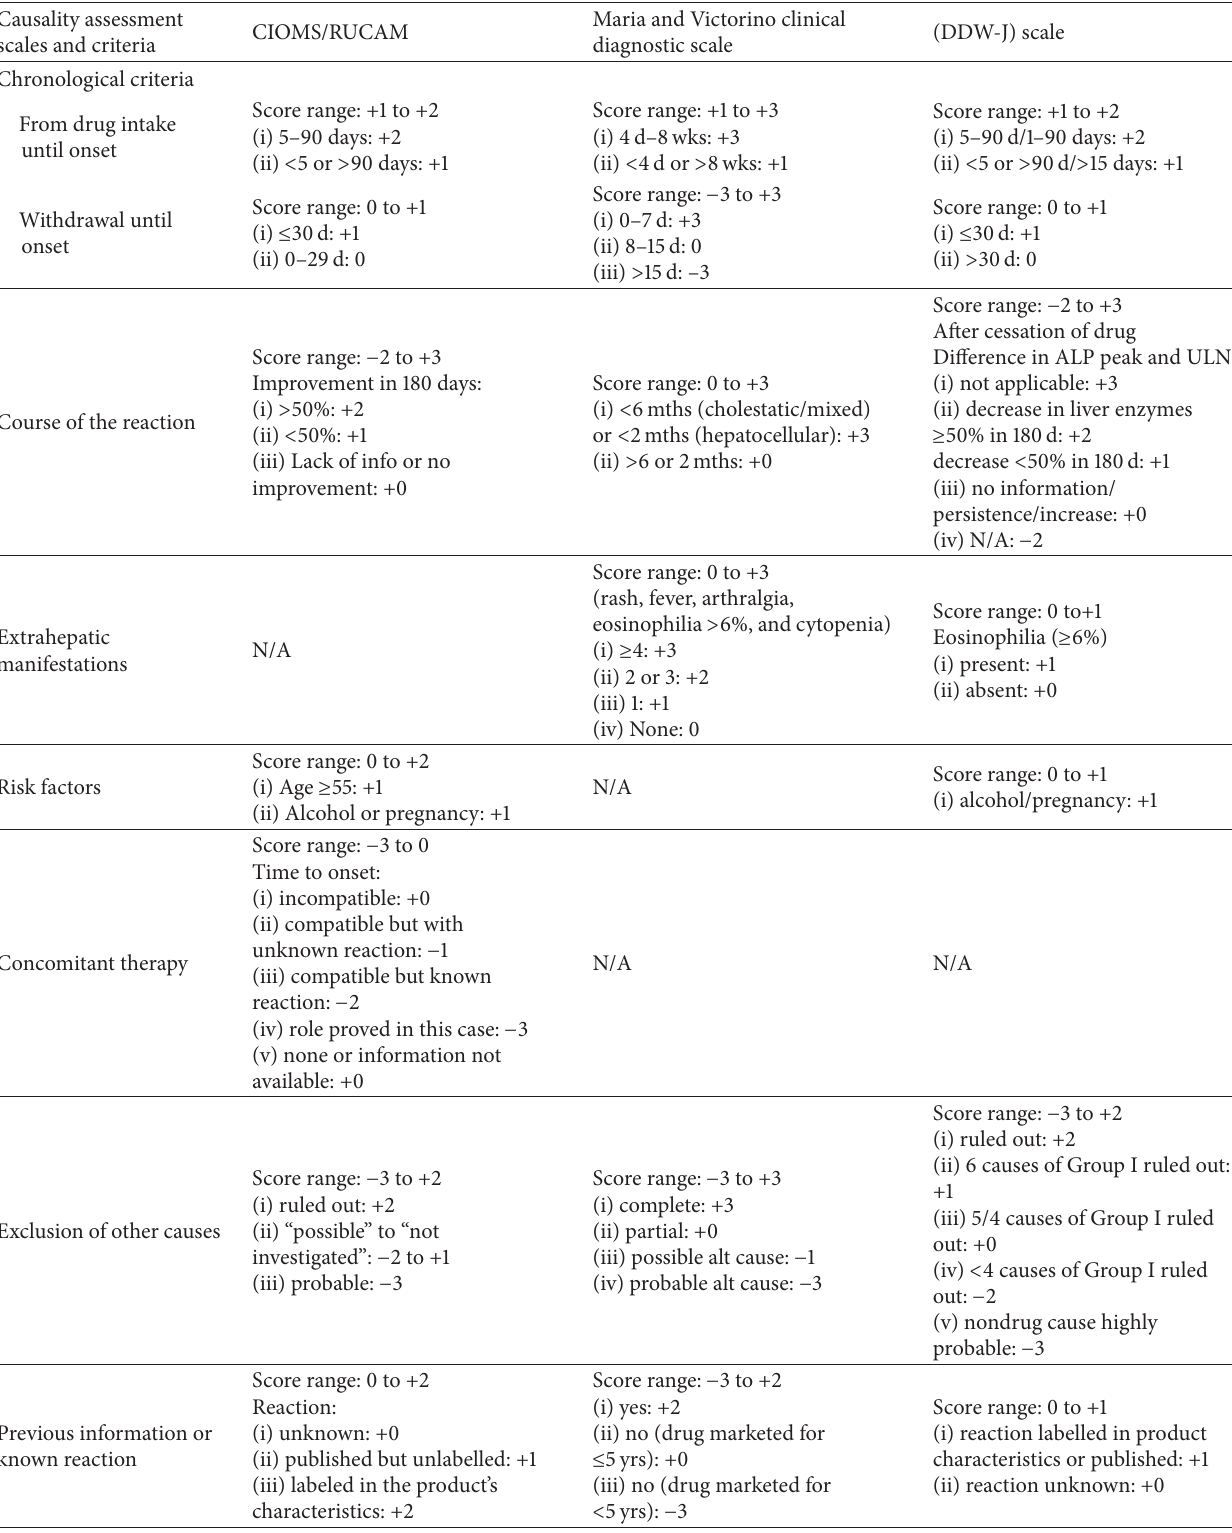
Table 2: Comparison of three liver-specific causality assessment scales on multiple sequential drug